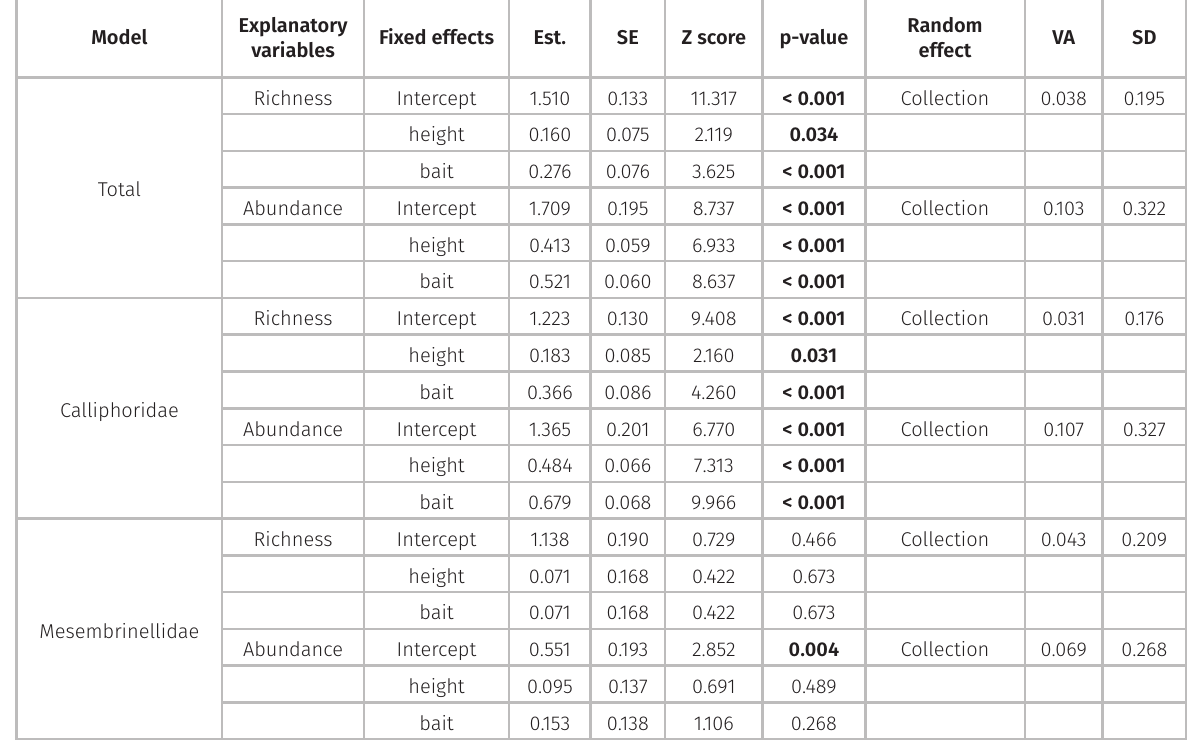
Table II. Parameters estimated by the Generalized Mixed Linear Model (GLMM) using Poisson distribution to assess if the richness and abundance of Calliphoridae and Mesembrinellidae species differ between baits and heights. The response variable was species richness and abundance, and the predictor variables are the fixed bait factors with two levels (bovine lung and banana) and height (low and high) and the random factor Collection with three levels (C1, C2 and C3). Estimative (Est.); Standard error (SE); Variance (VA); Standard deviation